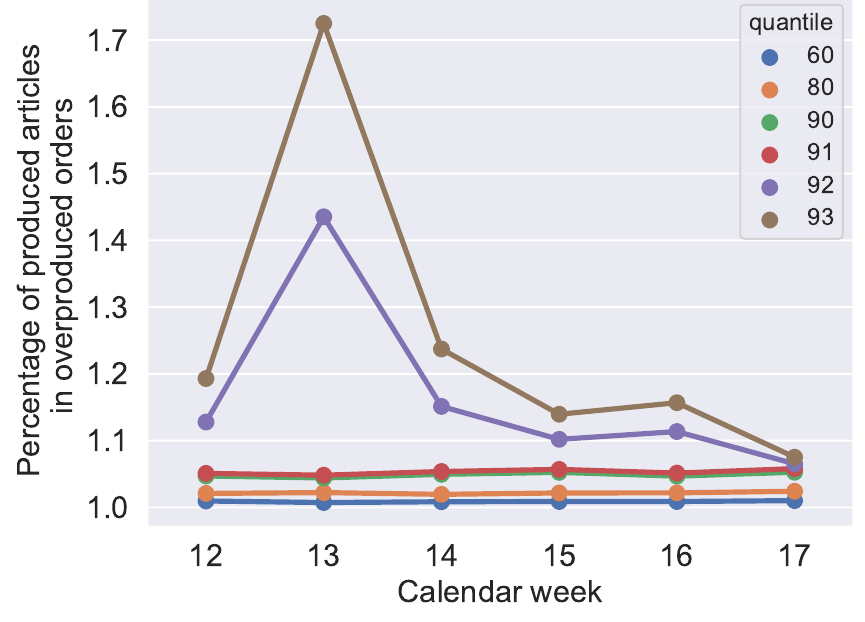
Figure 19. Average percentage of overproduction in orders producing too many items due to quantile